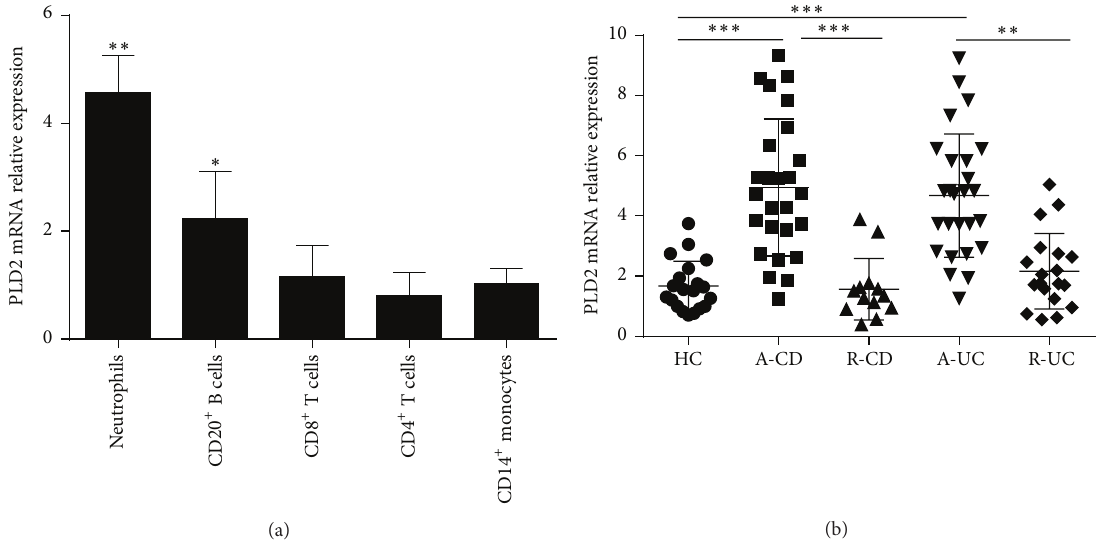
Figure 2: PLD2 is mainly expressed in neutrophils. (a) Expression of PLD2 in different subsets of immune cells. Peripheral neutrophils, CD20 + B cells, CD8 + T cells, CD4 + T cells, and CD14 + monocytes (1 × 10 6 ) were isolated from healthy donors ( 𝑛 = 10 ), and expression of PLD2 was detected by qRT-PCR. ∗ 𝑝 < 0.05 , ∗∗ 𝑝 < 0.01 , and ∗∗∗ 𝑝 < 0.001 versus CD14 + monocytes. (b) Neutrophils were isolated from peripheral blood of patients with A-CD ( 𝑛 = 26 ), R-CD ( 𝑛 = 23 ), A-UC ( 𝑛 = 26 ), R-UC ( 𝑛 = 19 ), and HC ( 𝑛 = 20 ). Expression of PLD2 mRNA was examined by qRT-PCR. ∗ 𝑝 < 0.05 , ∗∗ 𝑝 < 0.01 , and ∗∗∗ 𝑝 < 0.001 versus HC. Gene expression was normalized to GAPDH in each